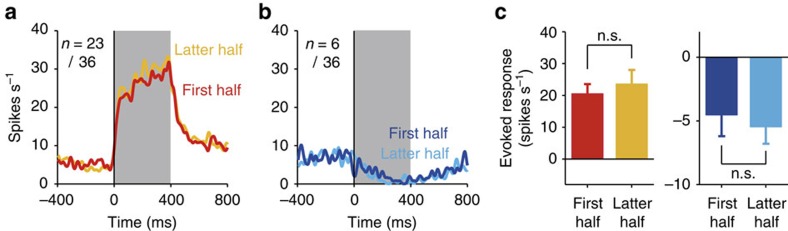
Repetition of laser light emission did not impair the firing ability of SC neurons.(a) Averaged activity of the 23 excited neurons in the ipsilateral condition. Spike density functions, in which each spike was replaced by a Gaussian curve (σ=10 ms), are aligned at the onset of the optical stimulation and shown for first half (red) and latter half trials (orange). (b) Averaged activity of the six suppressed neurons in the ipsilateral condition shown for first half (dark blue) and latter half trials (light blue). (c) Evoked-response magnitudes of the 23 excited (left) and 6 suppressed neurons (right) shown for first half and latter half trials. Error bars indicate s.e.m. n.s. indicates no significant difference (Wilcoxon signed-rank test, P>0.10).